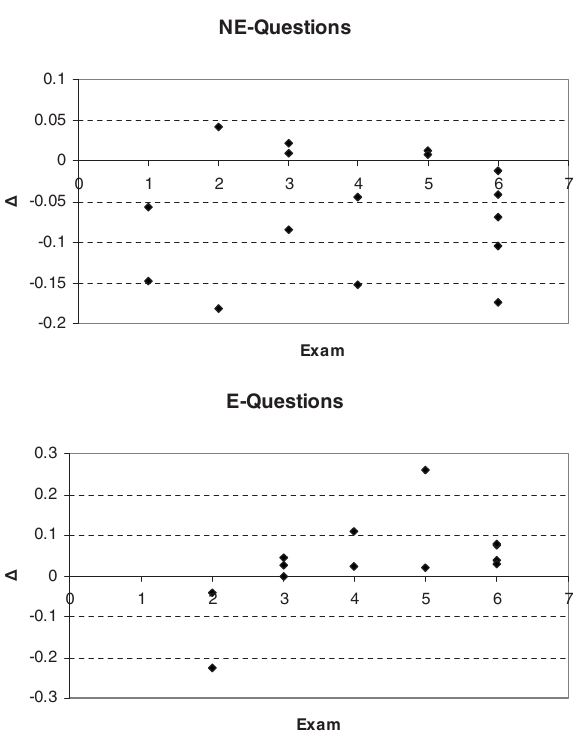
FIG. 3. Plots of the normalized difference between each condi- tion on multiple-choice exam